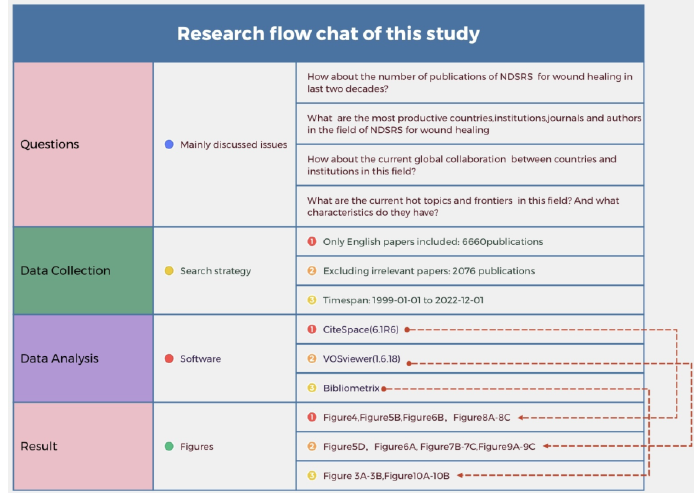
Figure 1. The flow chart of the scientometric study.